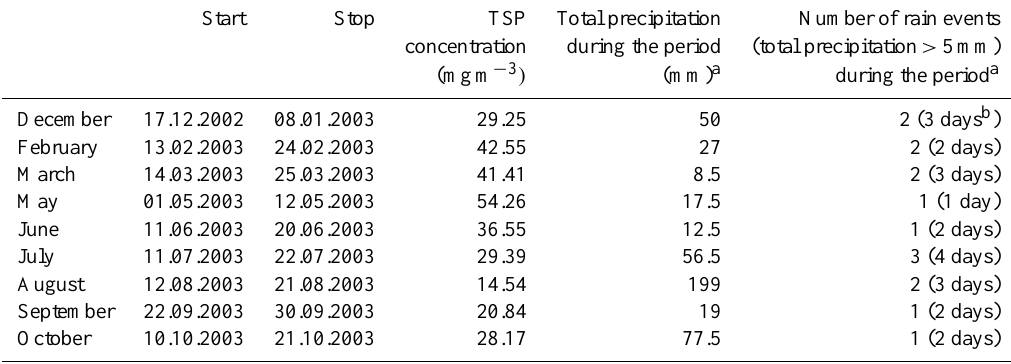
Table 1. Periods for the collection of the TSP samples used in this study. Start Stop TSP Total precipitation Number of rain events concentration during the period (total precipitation > 5mm) (mgm − 3 ) (mm) a during the period a 29.25 50 2 (3 days b ) 2 (2